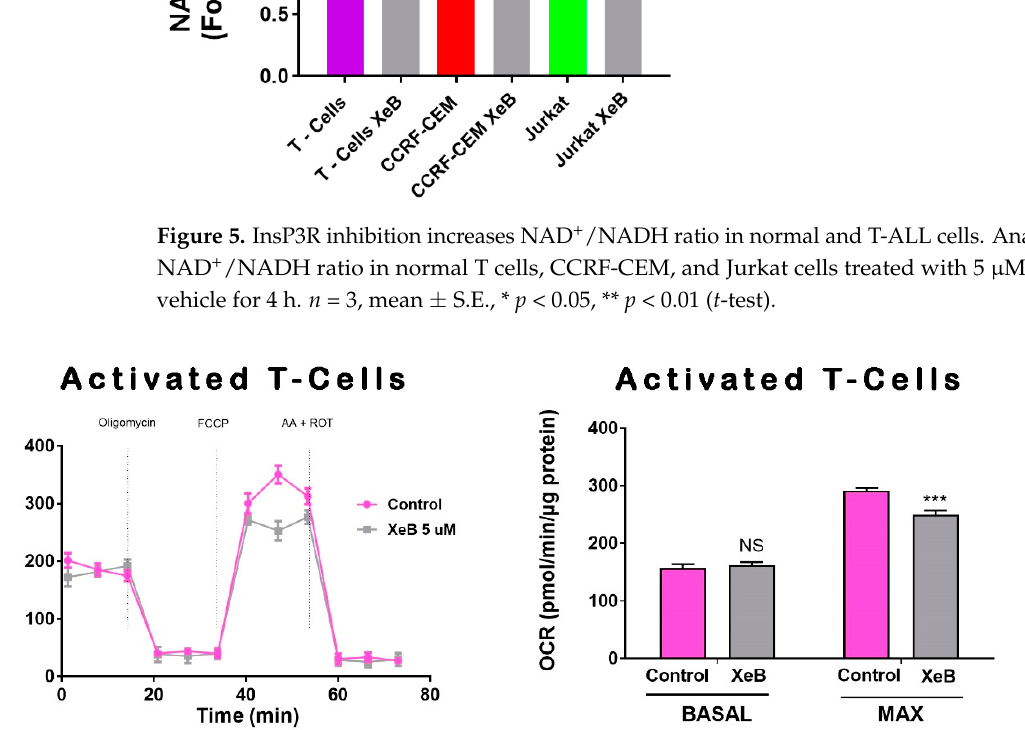
Figure 6. Effect of InsP3R inhibition on activated T-cells mitochondrial respiratory function. Representative oxygen consumption traces ( left ) and basal and maximal oxygen consumption rate (OCR) analysis of T-activated cell control or treated with 5 µM XeB ( right ). n = 3, mean ± S.E., *** p < 0.001, NS = not significant ( t- test).